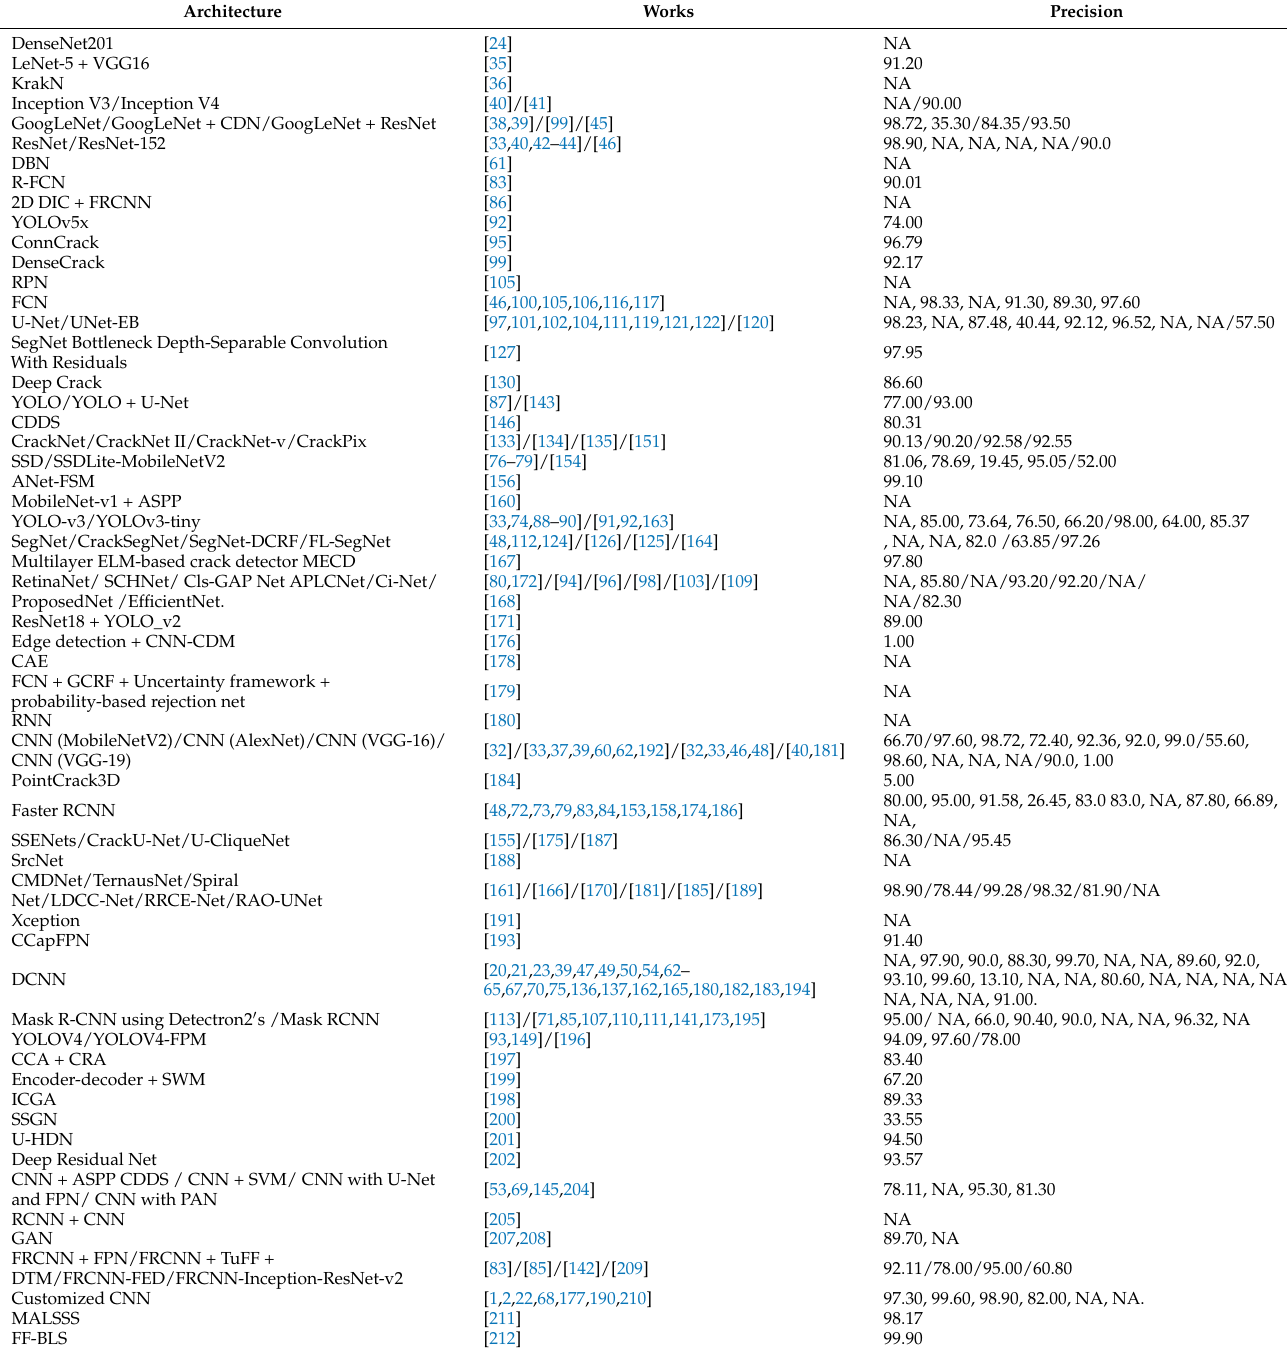
Table 12. Published articles on crack detection (domain